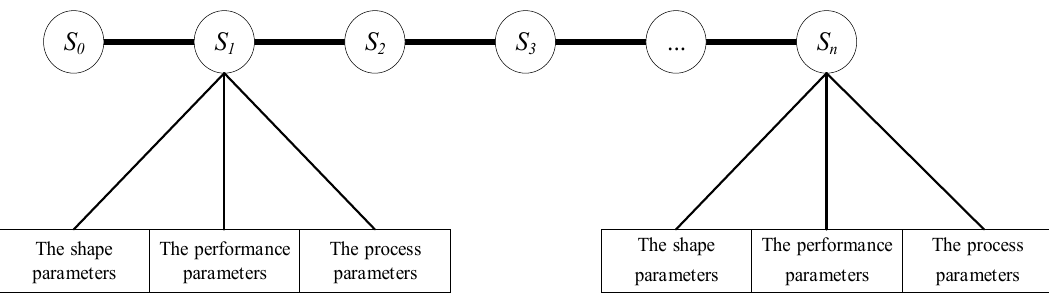
Figure 6. Profile discretization data representation.